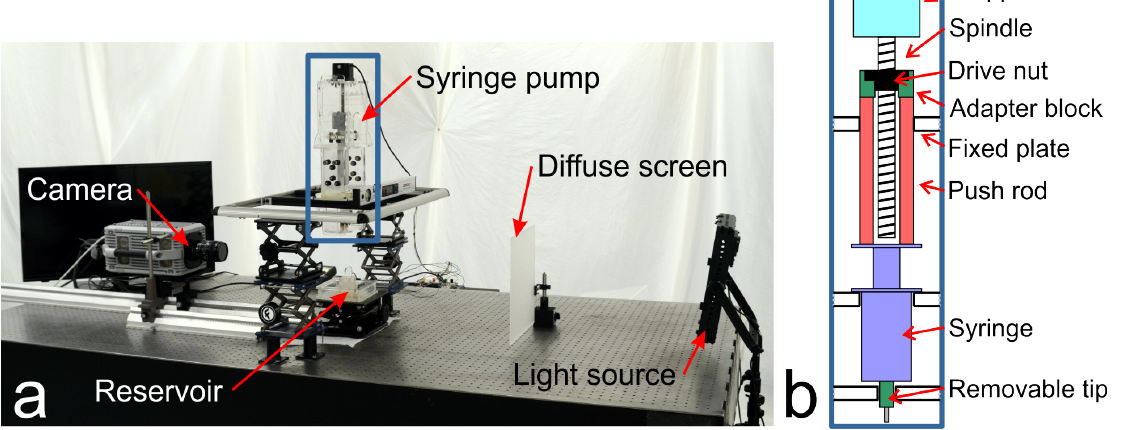
Figure 2. ( a ) An annotated photograph of the test setup in use, and ( b ) the schematic of the highlighted syringe apparatus with components